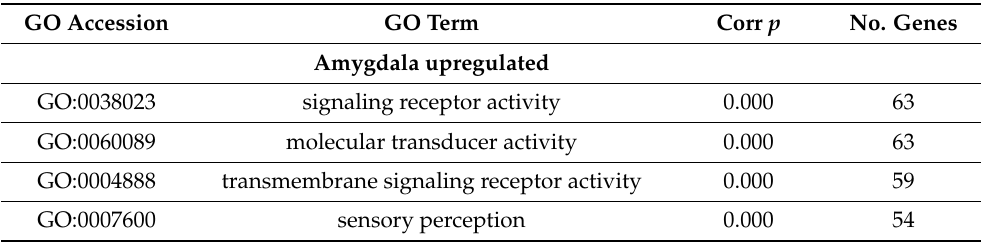
Table 6. Differentially expressed genes enriched in GO terms in stress-exposed rats after four